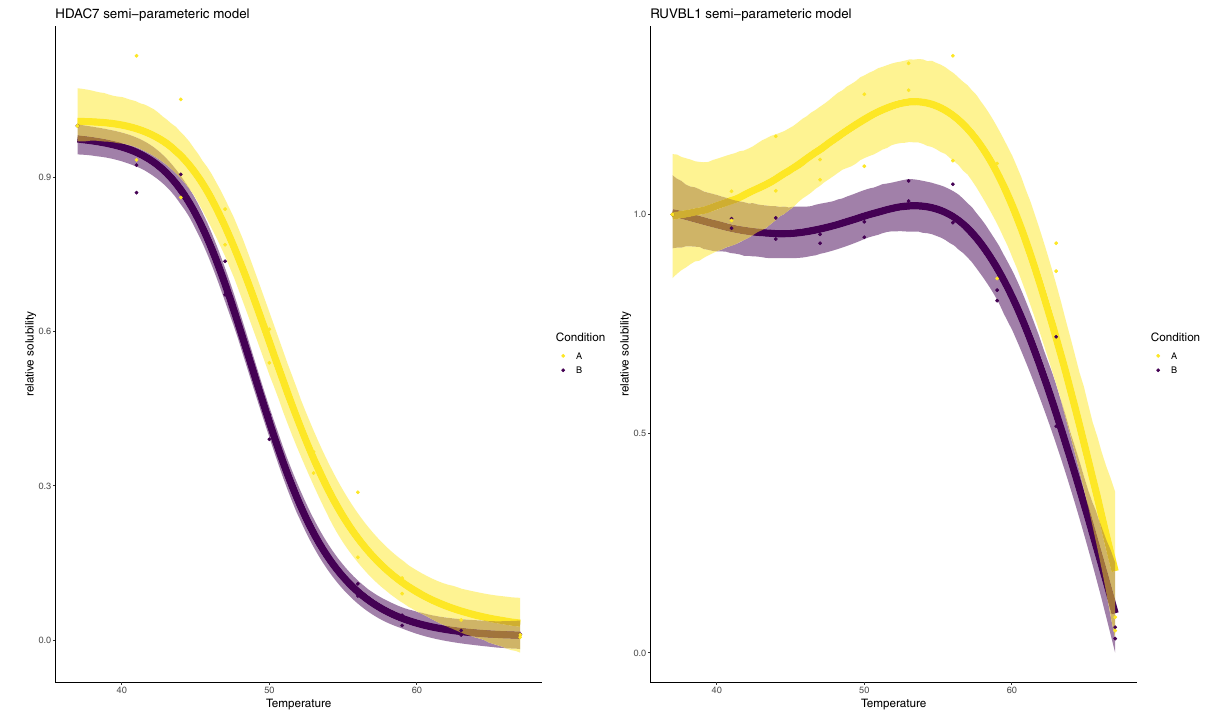
Fig. 4 Example model fi ts using semi-parametric model. Melting pro fi les for HDAC 7 and RUVBL1 using the Bayesian semi-parametric model. The points are observed protein data. The line represents the inferred mean function and the shaded region is the 95% credible band for the inferred mean function. Purple denotes the drug treated context, whilst yellow denotes the control. Statistics derived from two biological replicates, for each of two conditions each with 10 measure